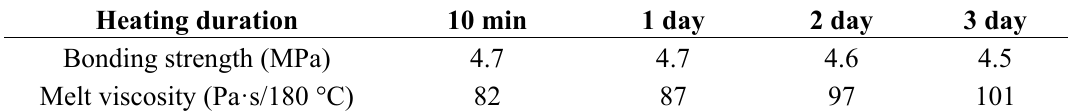
Table 4. Effect of heating duration on bonding strength and melt viscosity of